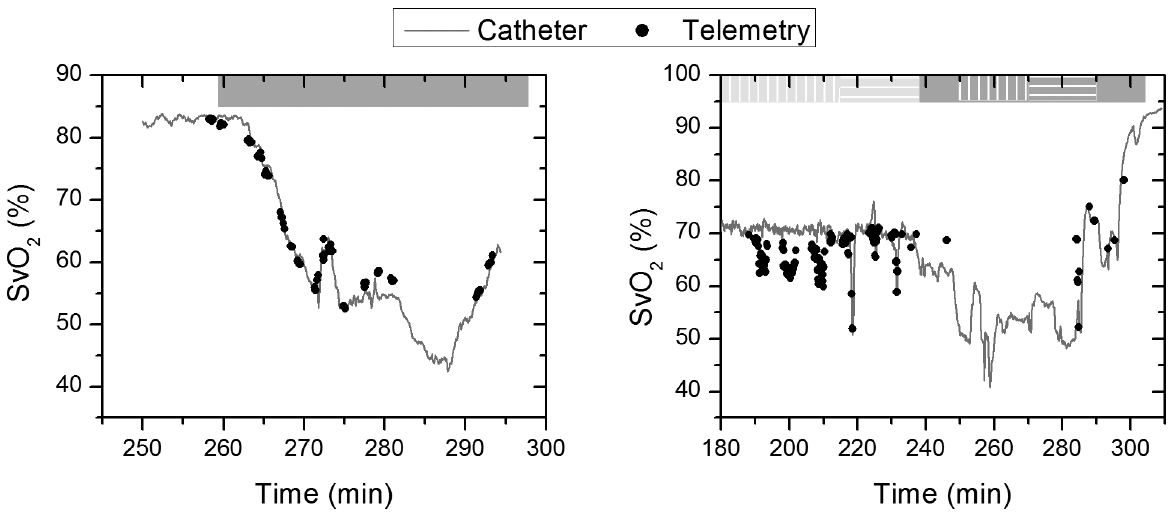
Figure 10. Predicted venous oxygen saturation by combining the DC NIRS measurements with the AC pulse oximetry measurements. Note that the missing values correspond to the periods where MOS dropped below 72% and, because of the previously reported problem with signal from the red wavelength, could not get reliable pulse oximetry measurements. Study 1 & 2 are shown in left & right panel respectively.